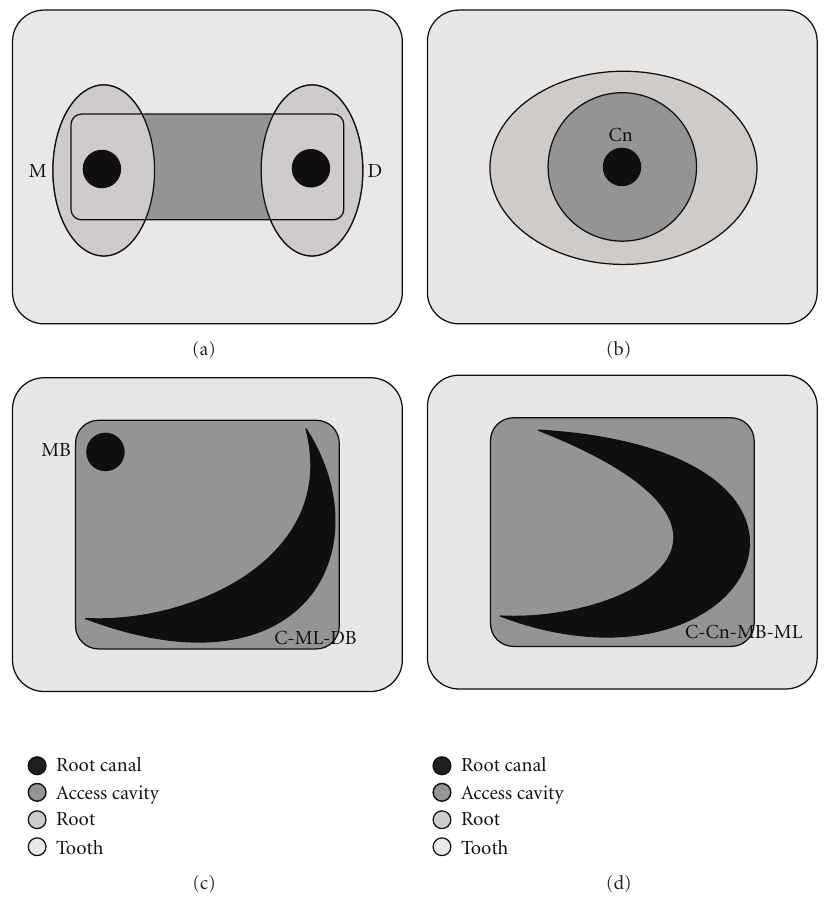
Figure 3: Diagrammatic representation of various root and canal configurations in mandibular molars named according to the proposed nomenclature. (a) A single canal in each principle root is named as mesial (M) and distal (D). (b) A single-rooted mandibular molar with a centrally located single canal is named as central canal, denoted as “Cn” . (c) Mandibular molar with a C-shaped canal extending from the mesiolingual (ML) to the distobuccal (DB) and a distinct mesiobuccal (MB) canal would be denoted as C-ML-DB, MB. (d), Mandibular molar with a C-shaped, centrally located canal extending from the MB to ML is denoted as